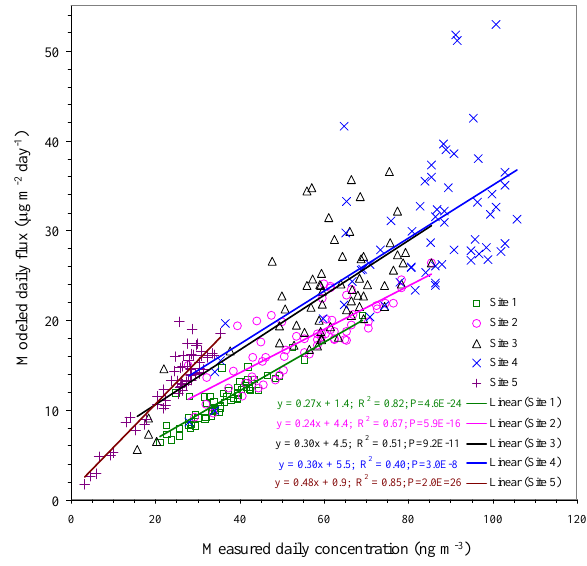
Fig. 5. Correlations between the modeled daily fluxes (µgm − 2 day − 1 ) and the measured daily concentrations (ngm − 3 ) for Mn at the five